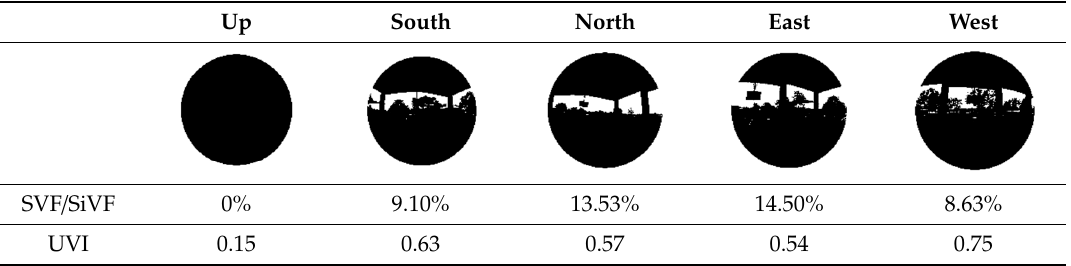
Table 5. Pebble Creek Elementary School (College Station, TX) basketball field UVR and Sky / Street view factor measurement in 5